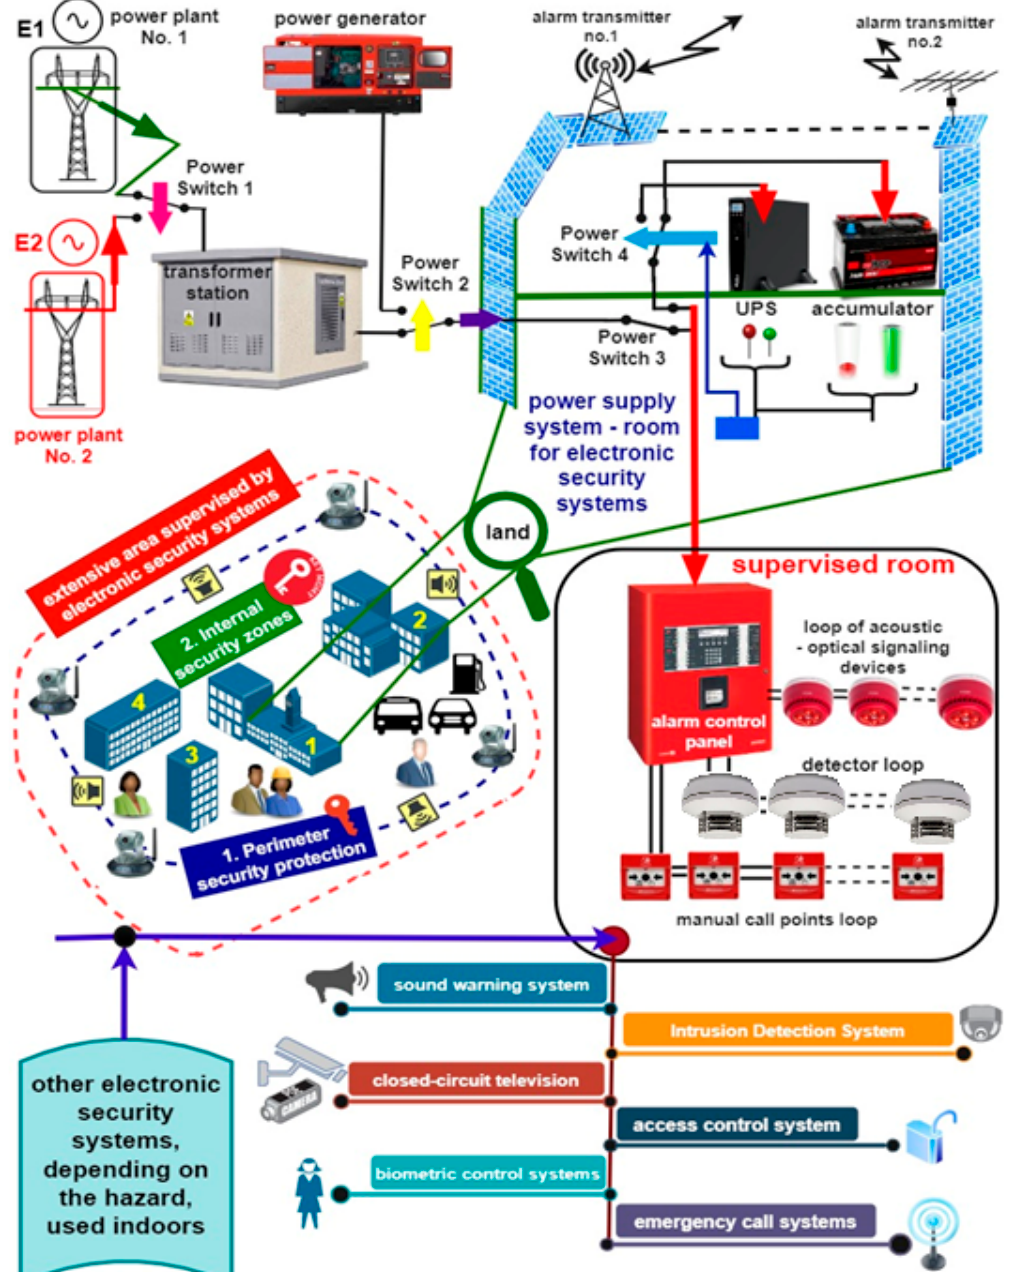
Figure 2. Implementation of the power supply for a vast area with located CI buildings No. 1, 2,